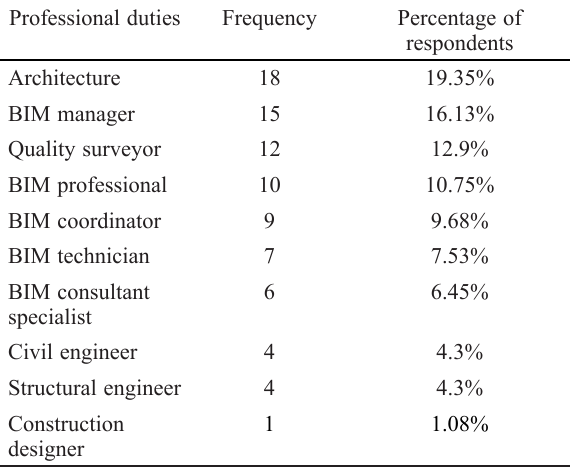
Table 5. Sample breakdown by professional